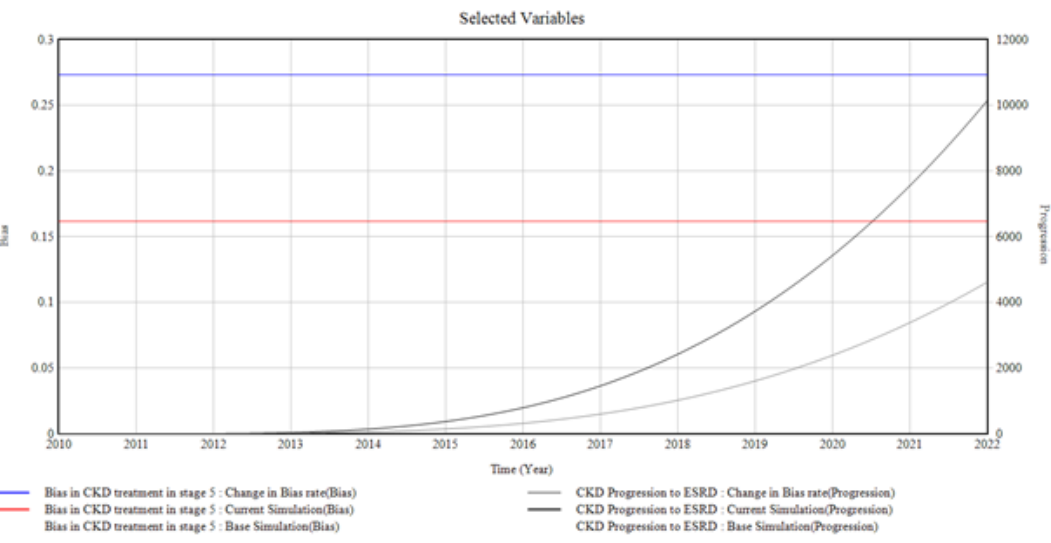
Figure 7. The Bias Rate in Stage 5 CKD vs. CKD Progression to ESRD.